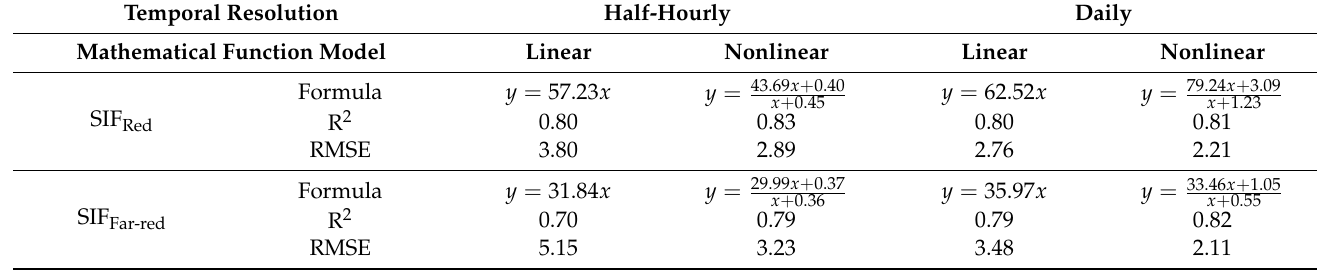
Table 1. Statistical results of linear and nonlinear fitting for SIF Red and SIF Far-red with GPP. Temporal Resolution